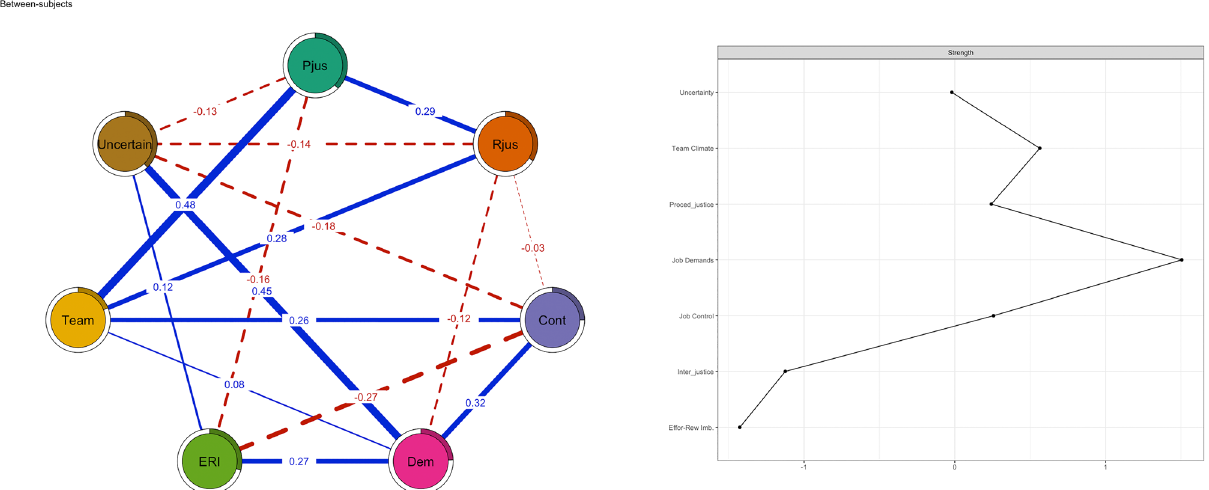
Figure 3. Between-individual longitudinal network (left panel) and strength (right panel) (procedural justice = pjus, interactional justice = rjus, effort-reward imbalance = eri, job demands = dem, job control = cont, uncertainty = uncer, team climate = team).